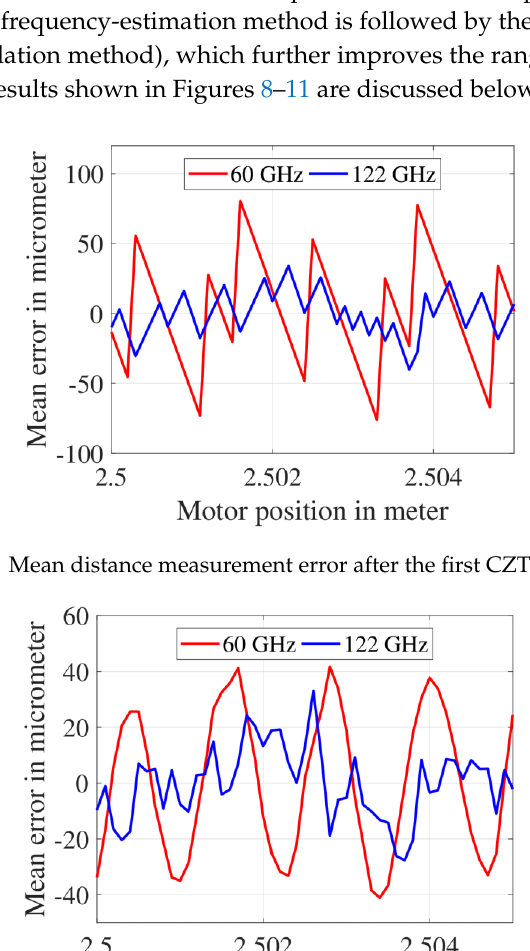
Table 2. Measurement summary of the 60 GHz and 122 GHz FMCW radar.